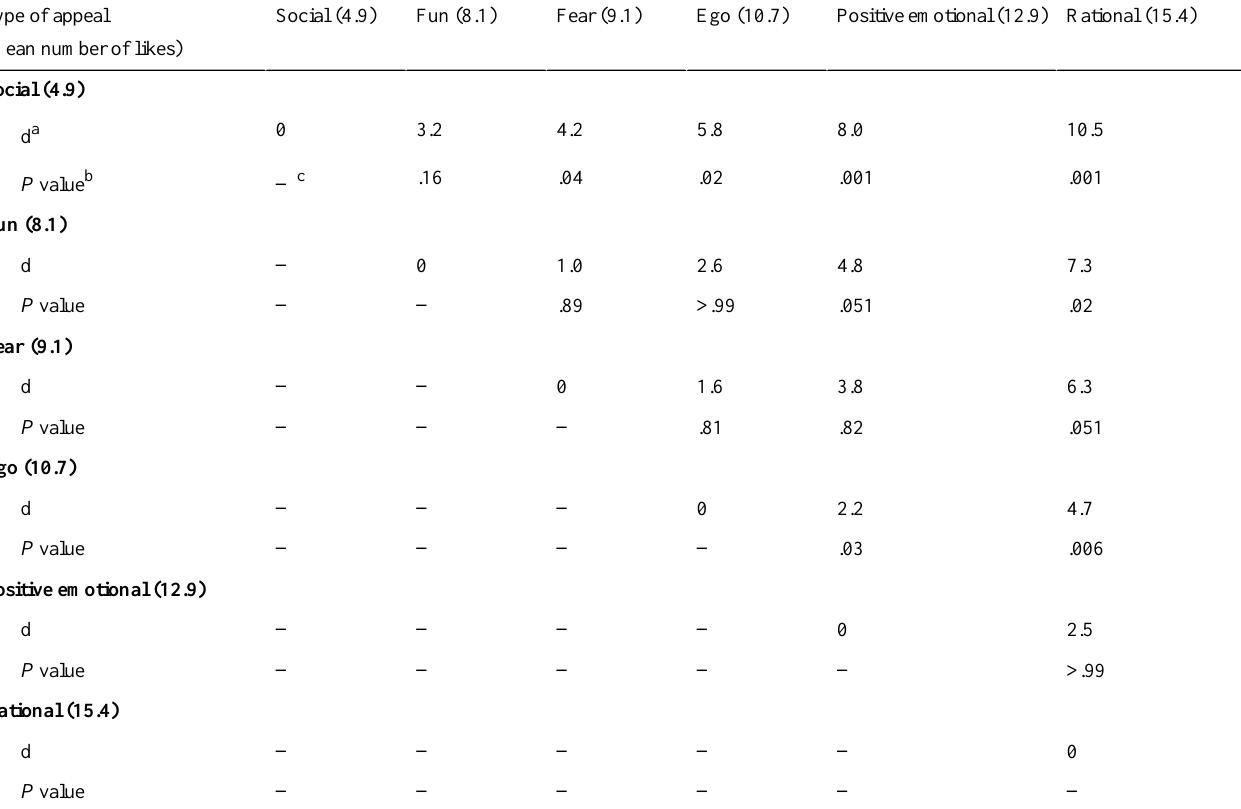
Table 2. Comparison of the mean number of likes among the different appeals in Instagram